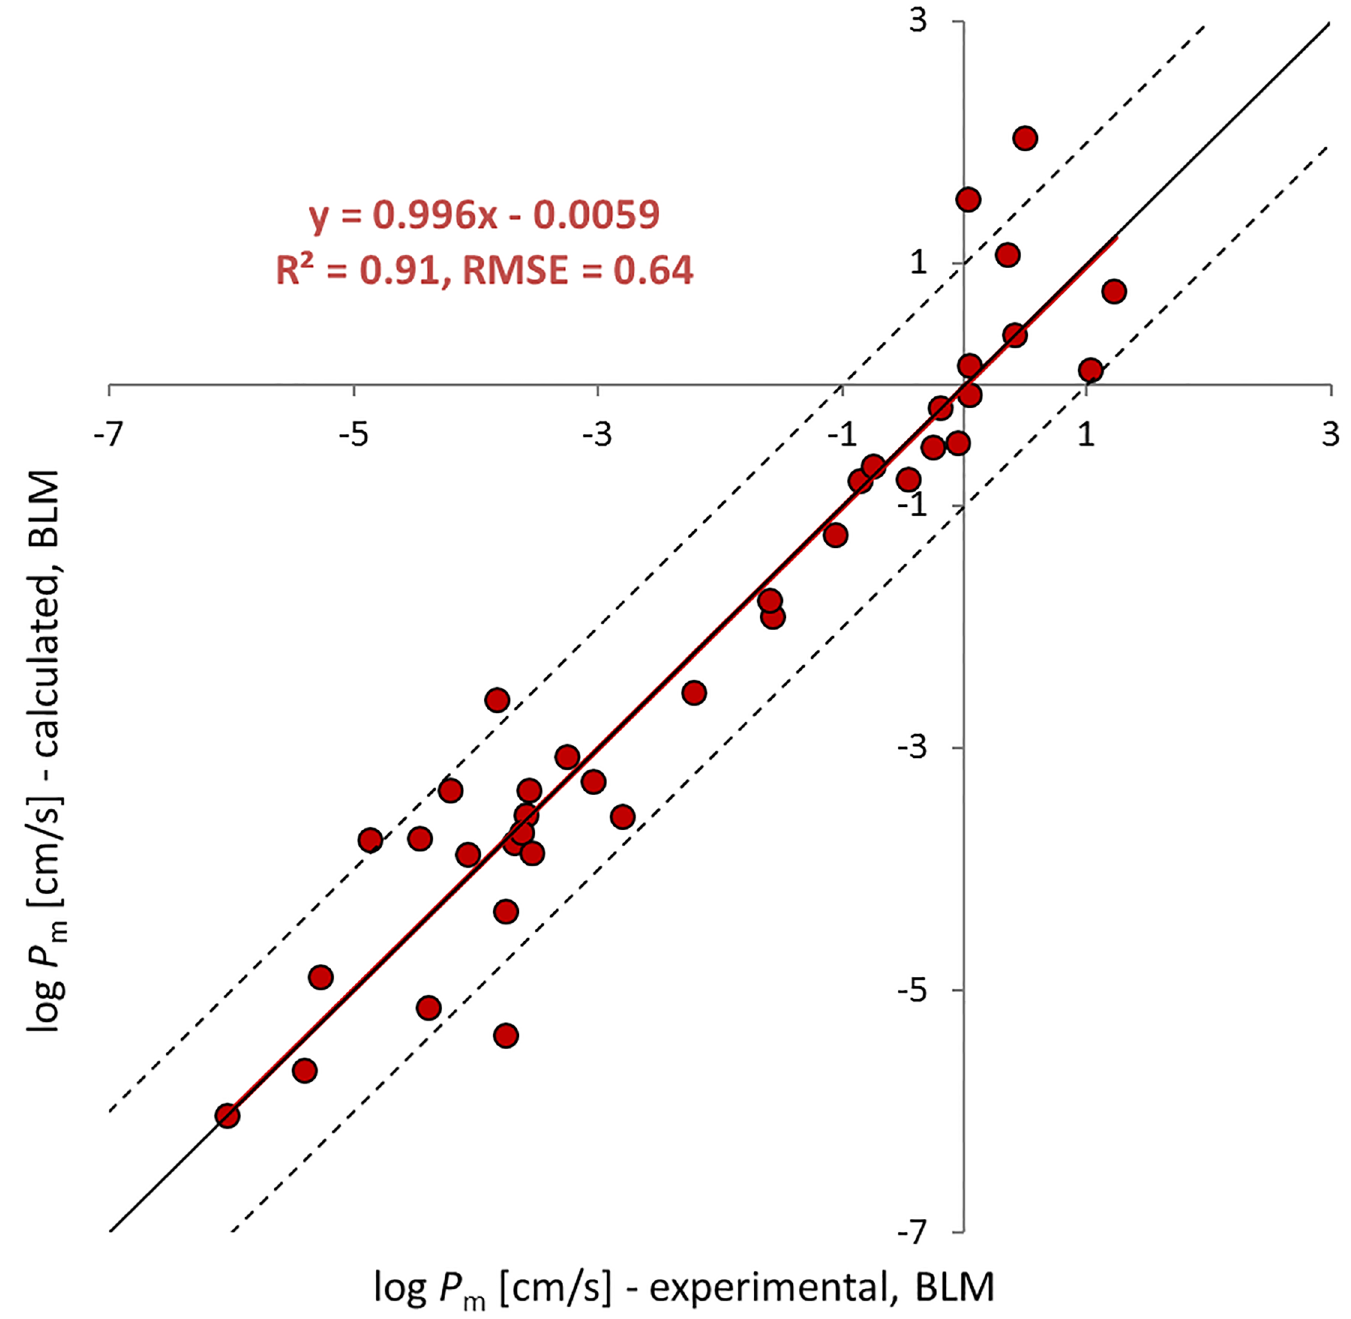
Fig 2. Prediction of BLM permeability with Eq (18) vs experimental values. As discussedin [13], the permeabilityof small moleculeswith molecular weights below50 is higherthan expectedwhen modeledwith the homogeneous solubilitydiffusion model. This has been explained by a polymer-like behavior of the membranethat differs from the liquidhydrocarbon-likebehavior, which is implicitlypresumedin the model. Hence, we excludedthe nine smallest moleculeswith molecularweights < 50 (see SI for all values).